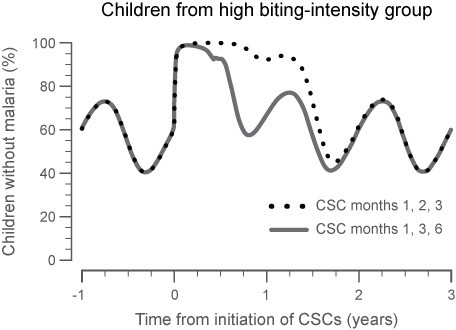
Impact of the study treatment on parasite prevalence within a population, with moderate transmission intensity (M = 1.25, EIR < 100) and CSC scheduled at months 1, 2 and 3 or months 1, 3 and 6 of the dry season. The panel shows the percentage of children < 5 years of age who are parasite free in the high-biting group. By repeatedly screening the population and treating the asymptomatic carriers at short time intervals, the rate of parasite prevalence can be reduced for two consecutive years as determined by the area under the curve for each year.